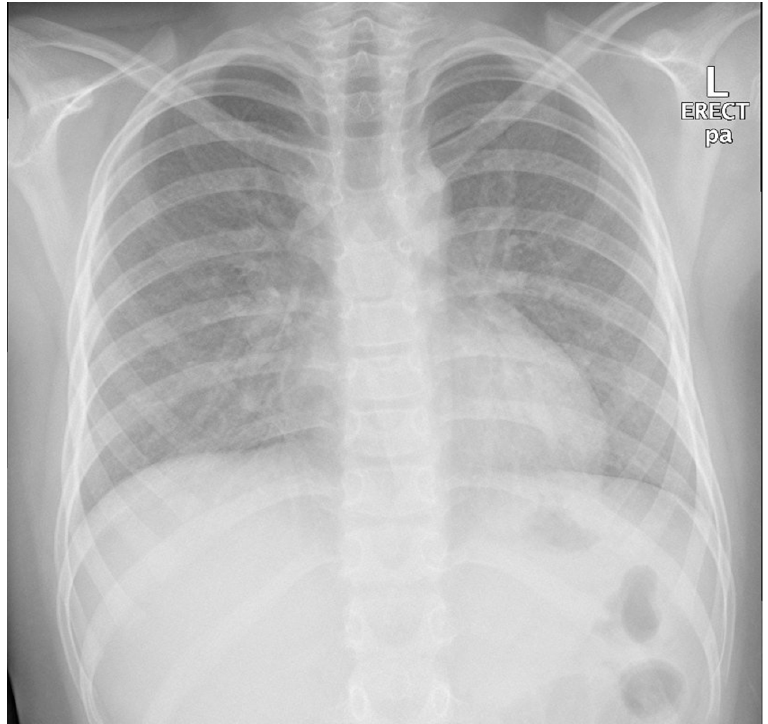
Figure 1. Patient first chest X-ray (CXR) showed bilateral diffuse miliary nodules.